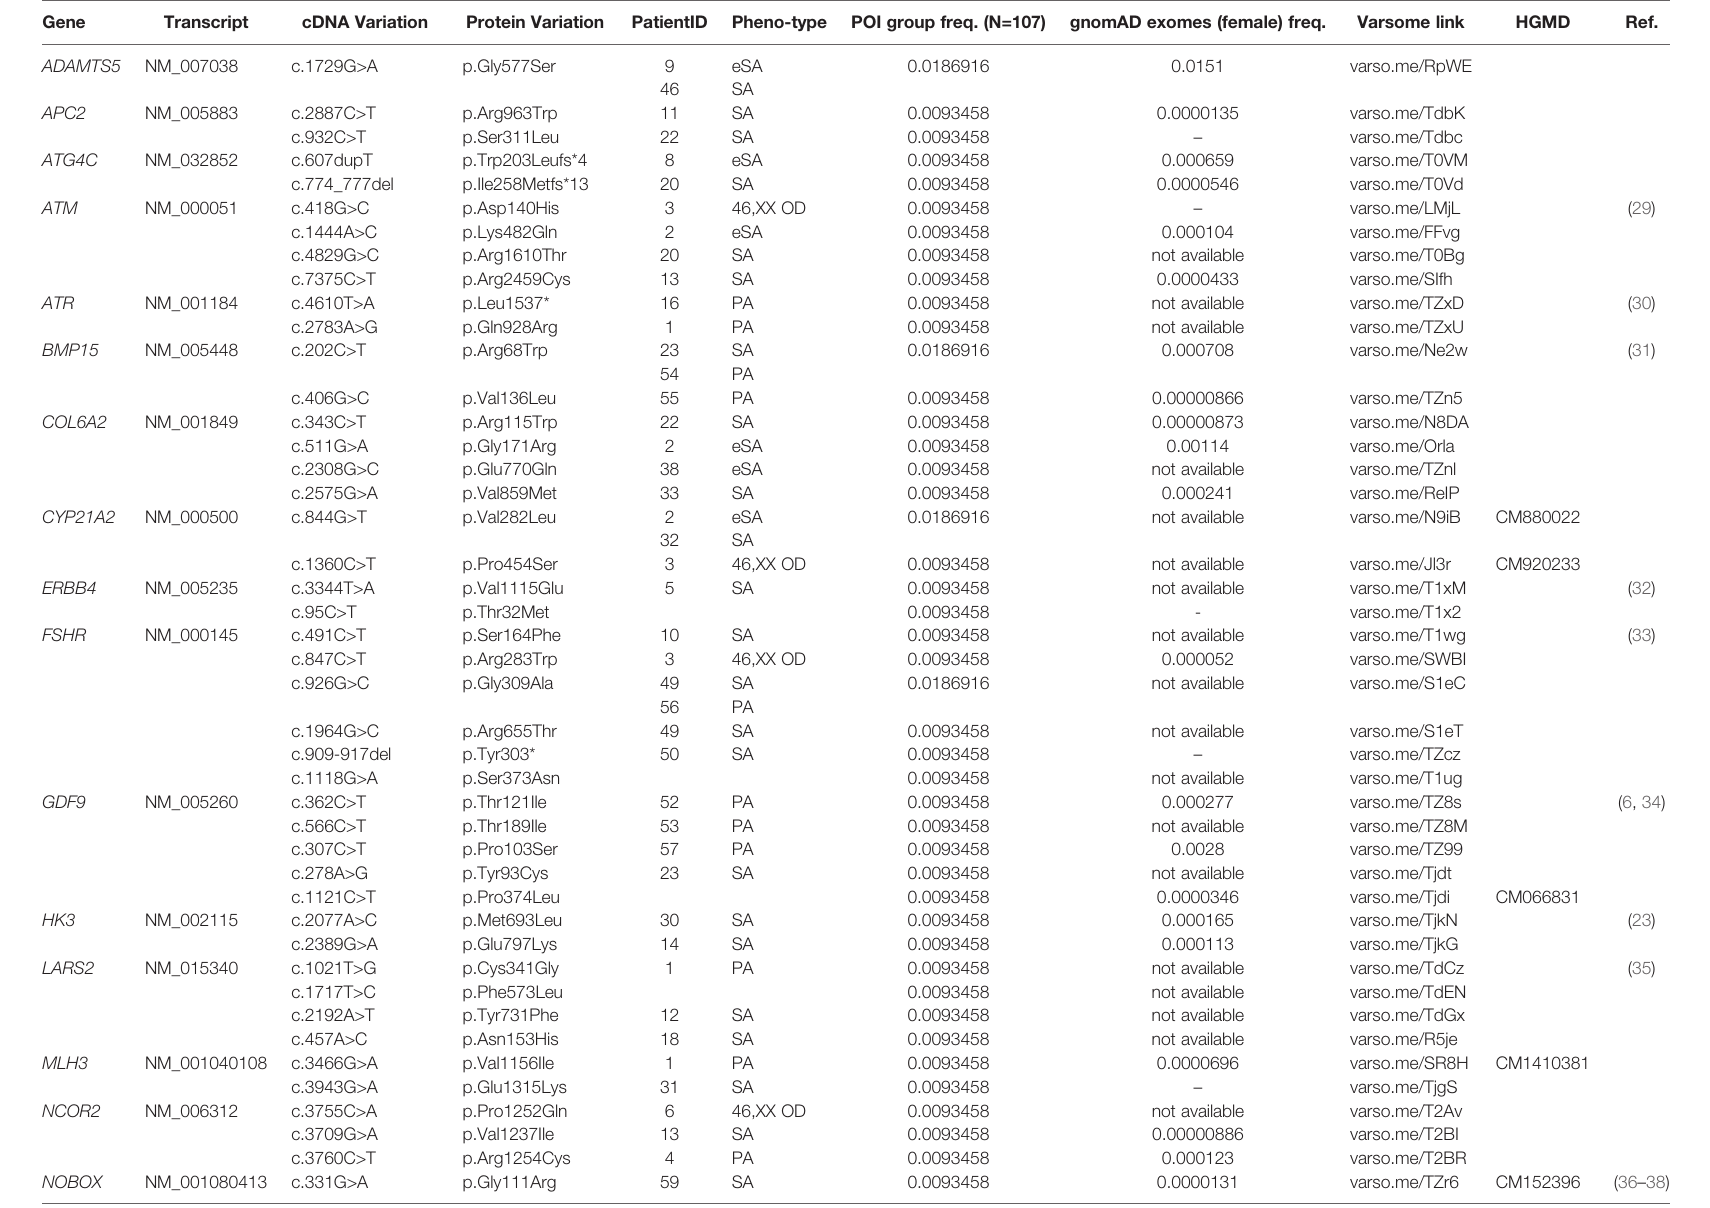
TABLE 7 | Summary of the recurring variants in our POI cohorts.